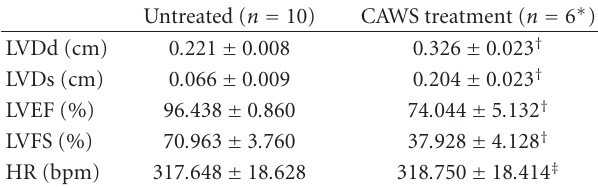
Table 1: Cardiac parameter calculated from